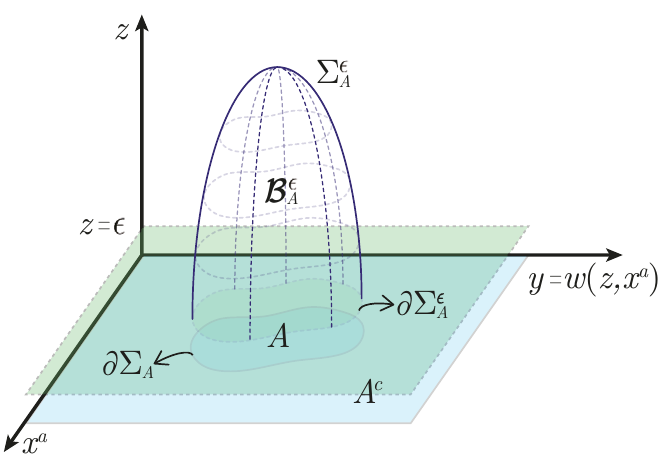
Figure 1 . The RT surface and the subregion volume embedded into the asymptotically AdS d +1